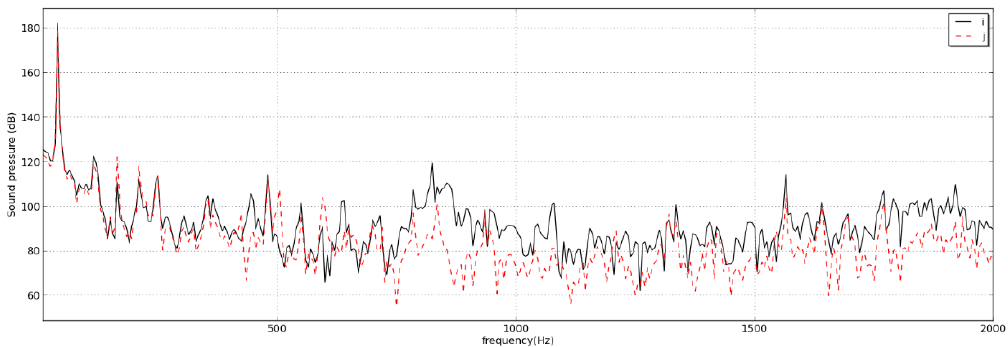
Figure 11. Curves of sound pressure levels from points a and b. The continuous black line denotes the sound pressure level of point a, while the red dot line denotes the sound pressure level of point b.